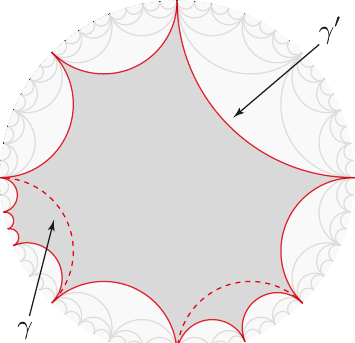
Figure 11 . Example of a cuto(cid:11): a convex (cid:12)nite area bounded by a closed curve of (cid:12)nitely many geodesics of a given tessellation.